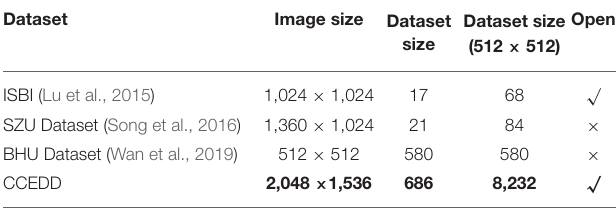
TABLE 1 | Comparison with other cervical cytology datasets.